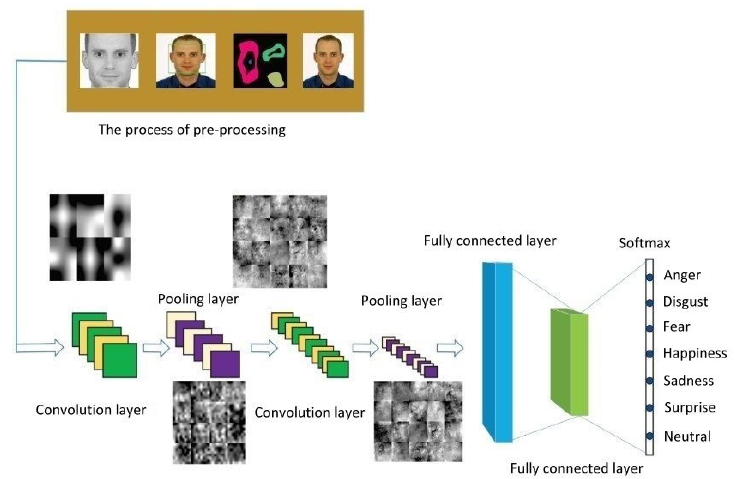
Figure 2. CNN architecture of human facial expression image recognition.